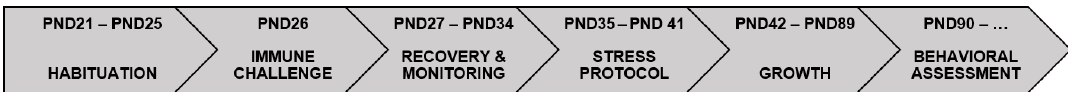
Figure 1. Experimental procedure illustrated in a timeline. Animals were assigned to four experimental conditions concerning exposure to lipopolysaccharide (LPS) and stress: saline-control (SAL/S-), LPS-control (LPS/S-), saline-stress (SAL/S+), or LPS-stress (LPS/S+), and habituated to the laboratory until PND26, where the immune challenge took place. The following days the functional observational battery (FOB) was employed to assess illness symptoms. Between postnatal days 35 and 41 (PND35 and PND41), four stressors were applied on non-consecutive days. After stress protocol, rats were left undisturbed until behavioral assessment started at PND90. Once finished, animals were sacrificed by decapitation and their brains removed and stored at −80 °C for further processing.